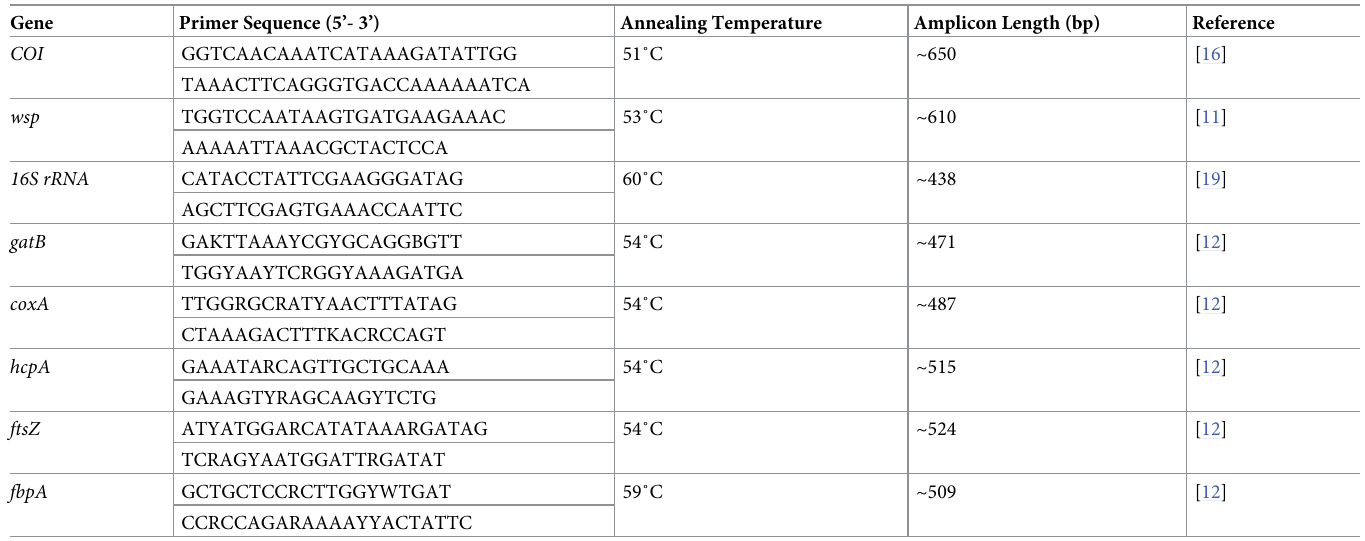
Table 1. Primer pairs used in this study. Gene Primer Sequence (5’-